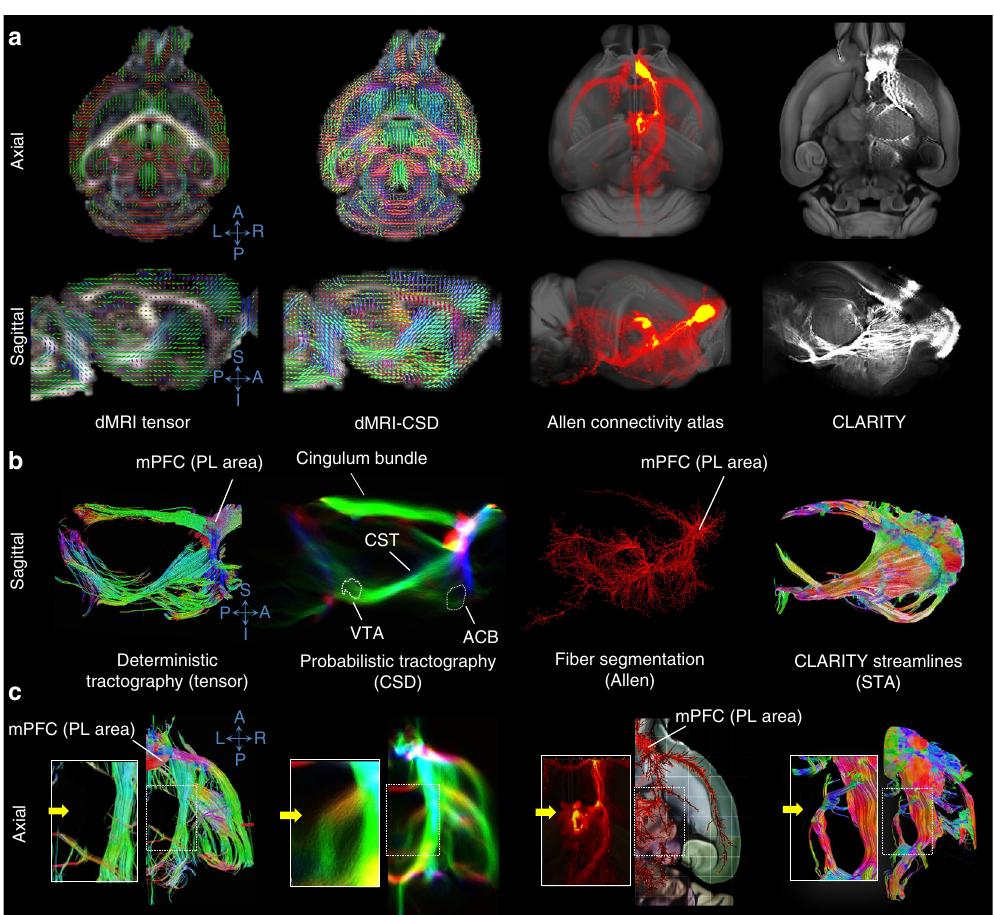
Fig. 7 Examining prefrontal fi ber projections using dMRI, the Allen connectivity atlas, and CLARITY viral tracing. a Raw and processed data across different connectivity scales (axial and sagittal views). Left panel: Ex vivo diffusion tensors (primary eigenvector for each voxel) overlaid on a fractional anisotropy (FA) map. Center left panel: Fiber orientation distribution computed using a constrained spherical deconvolution model (CSD, ref. 44 ) and overlaid on the FA map. Center right panel: Projection density map from a medial prefrontal cortex (mPFC) injection from the Allen connectivity atlas (red), overlaid on the 3D ARA template (grayscale). Right panel: Raw images from an example CLARITY viral tracing experiment with an mPFC injection, overlaid on a slice from the ARA template. A – P: anterior – posterior, R – L: right – left. b Tractography and fi ber segmentation across different modalities from a sagittal view. The fi rst two images show fi ber tractography streamlines from diffusion MRI with different tracking techniques (deterministic tensor and probabilistic CSD), followed by a rendering of Allen connectivity, and lastly structural tensor analysis (STA) reconstructed streamlines from CLARITY in a . ACB: nucleus accumbens, CST: corticospinal tract, PL: prelimbic area of mPFC, VTA: ventral tegmental area. S – I: superior – inferior, R – L: right – left. c Resolving branching of fi bers projecting from the prelimbic area (PL) to the mediodorsal nucleus of the thalamus (yellow arrow). Deterministic tensor tractography fails to capture this fi ber branching, while probabilistic CSD tractography reproduced this projection that was con fi rmed in the Allen atlas and our CLARITY viral tracing brain atlas and the average of our segmented CLARITY viral tracings, with voxel-wise Spearman ’ s correlations of r s = 0.31 ( p < 0.0001) and r s = 0.35 ( p < 0.0001), respectively (Supplemen-